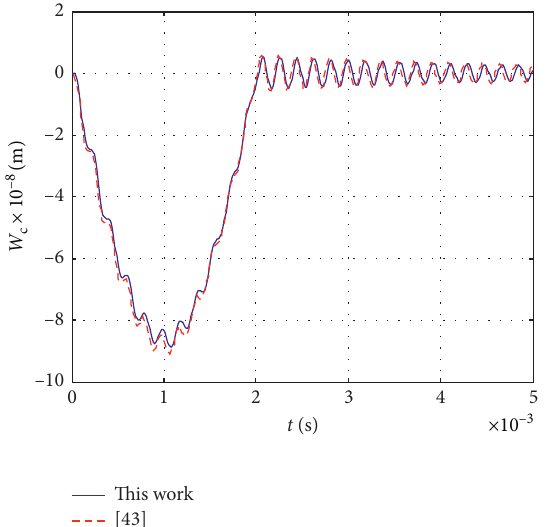
Figure 3: Comparison of the center point deflection changing by the time of the piezoelectric FGM plate, n � 2.